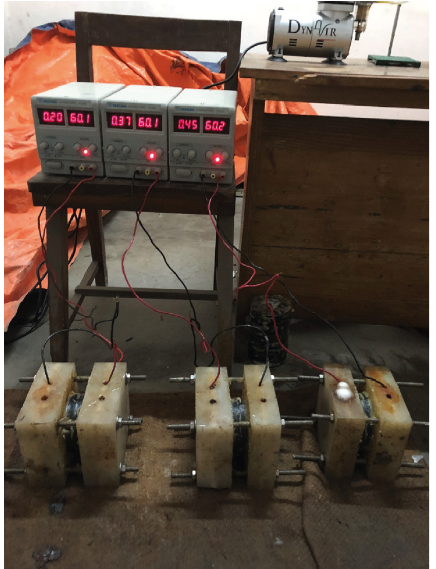
Figure 9: RCPT test being